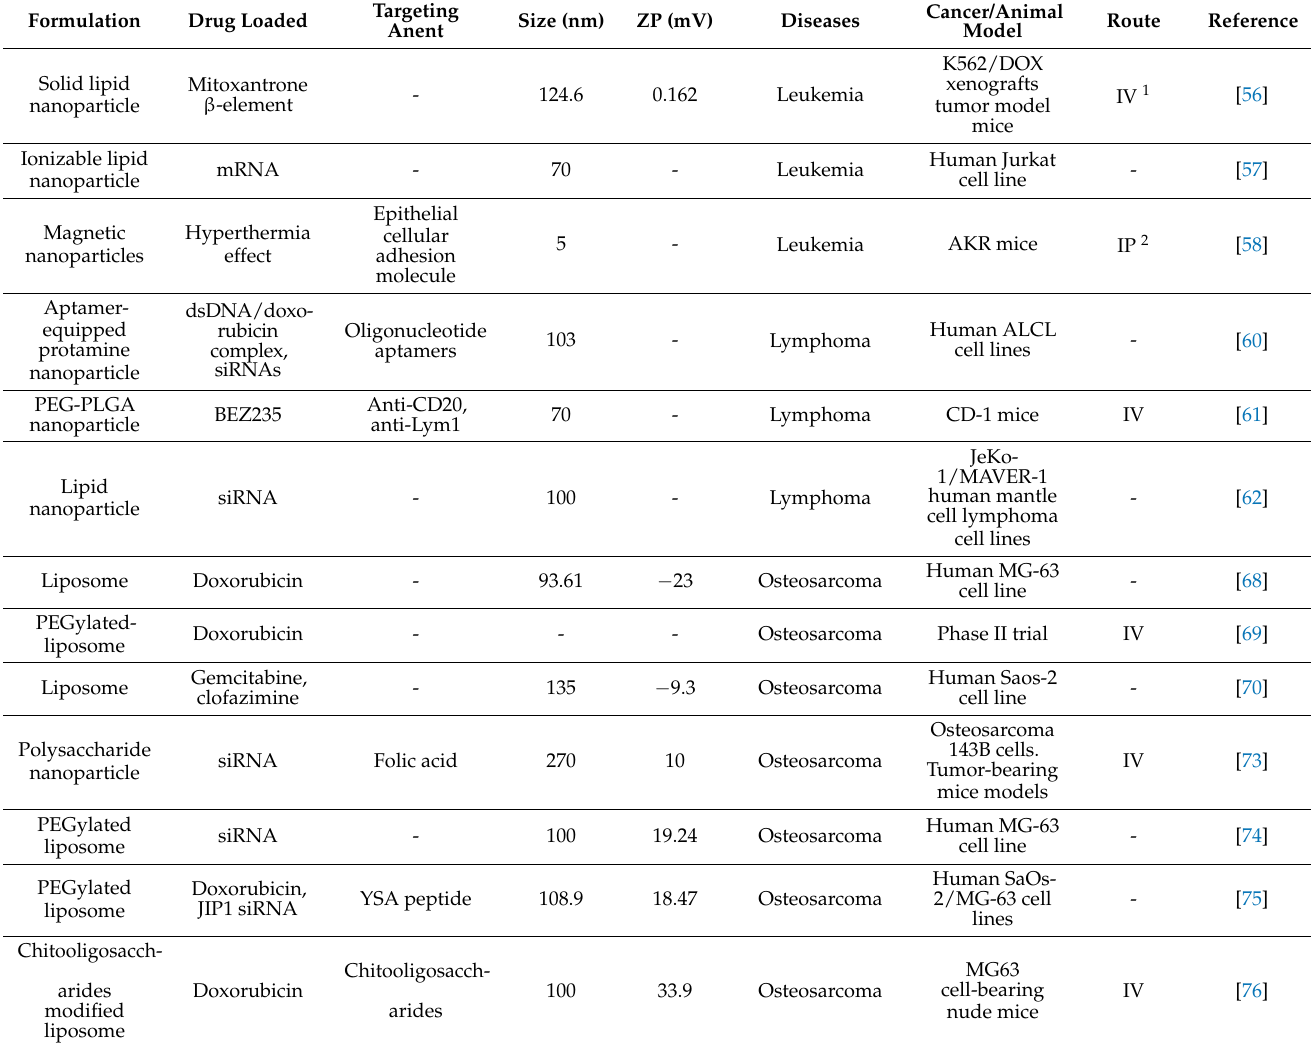
Table 2. Nanoformulations discussed in this